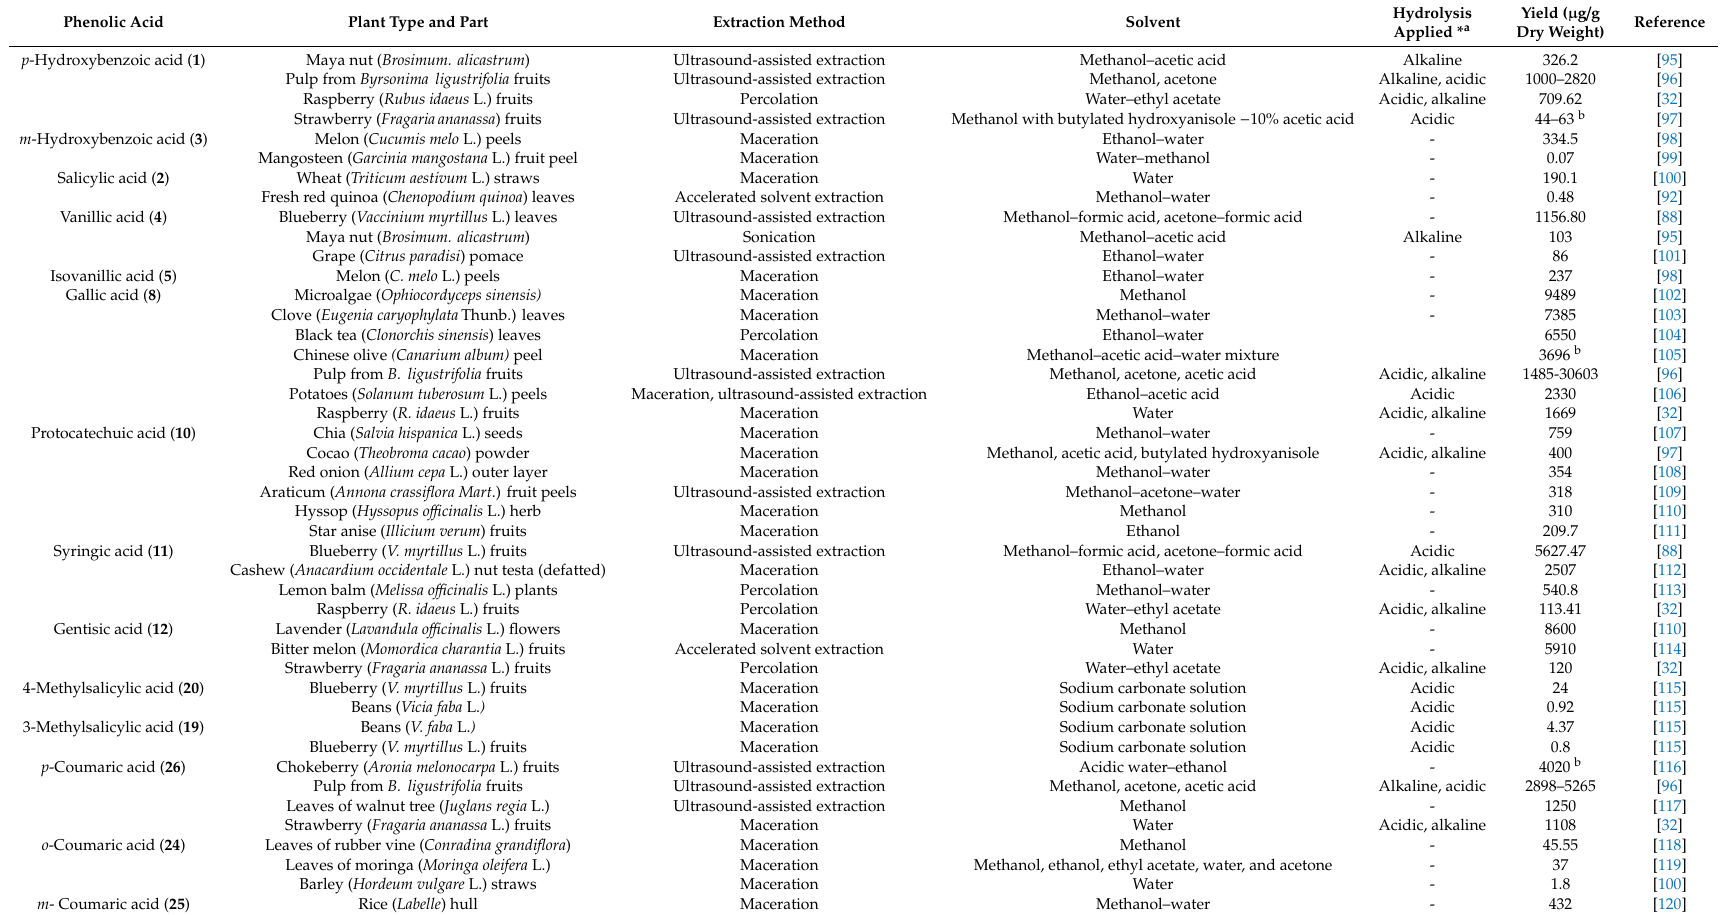
Table 3. Yields of free phenolic acids extracted from